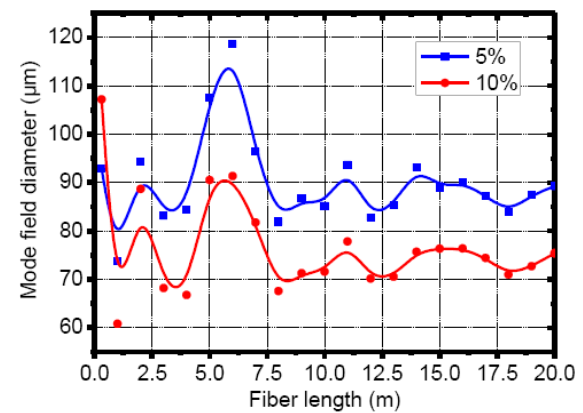
Figure 8. Evolution of the mode field diameter inside the core of the